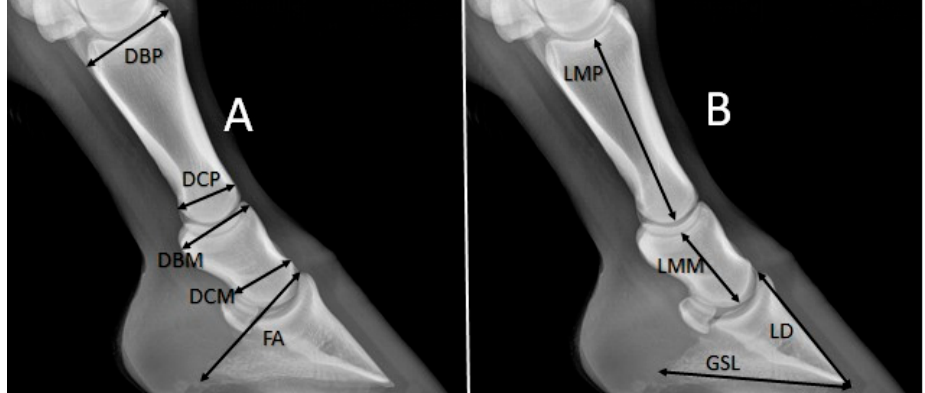
Figure 1. Measurement (4-year-old male Arabian horse). ( A ): Depth of the basis of the proximal phalanx (DBP), depth of the caput of the proximal phalanx (DCP), depth of the basis of middle phalanx (DBM), depth of the caput of the middle phalanx (DCM), length of the caudo-dorsal surface of the distal phalanx (FA). ( B ): Length of the middle of the proximal phalanx (LMP), length of the middle of the middle phalanx (LMM), length of the dorsal surface of the distal phalanx (LD), greatest solear length of the distal phalanx (GSL).